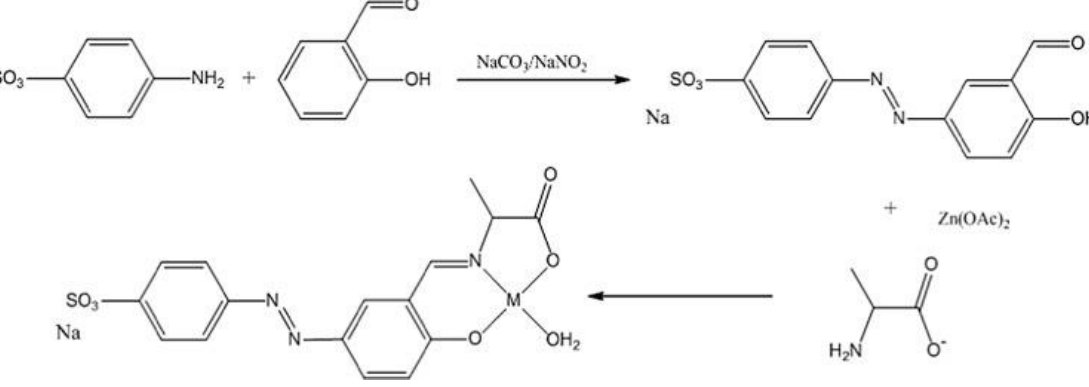
Figure 2. The synthesis of the trimodal zinc complex AzZnSA